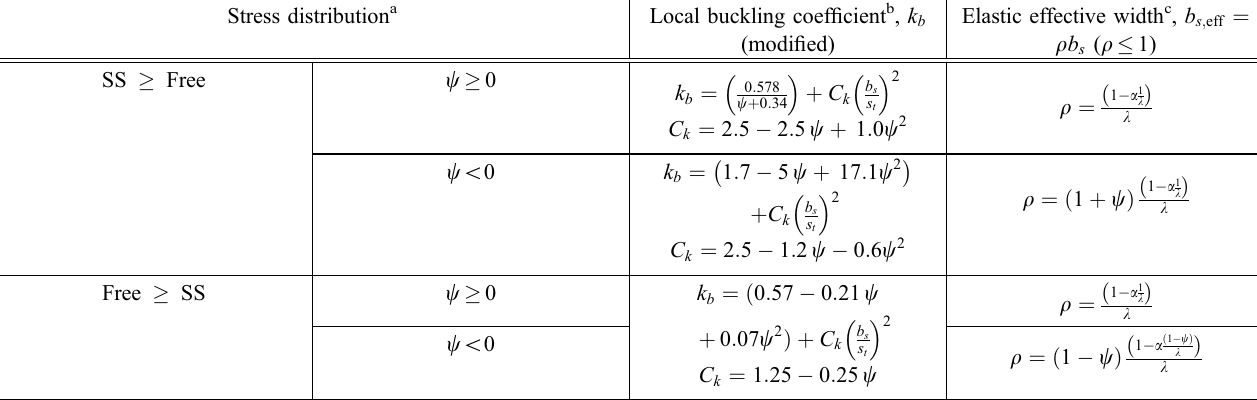
Table 2 Effective width for legs of steel angles (Bambach and Rasmussen (2004a, b) and modification). Stress distribution a